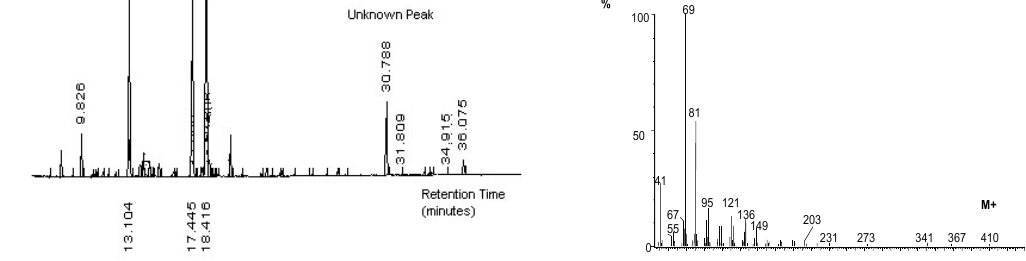
Fig. 2a. Gas chromatogram of neutral lipid fraction of reindeer meat, showing the unknown peak.